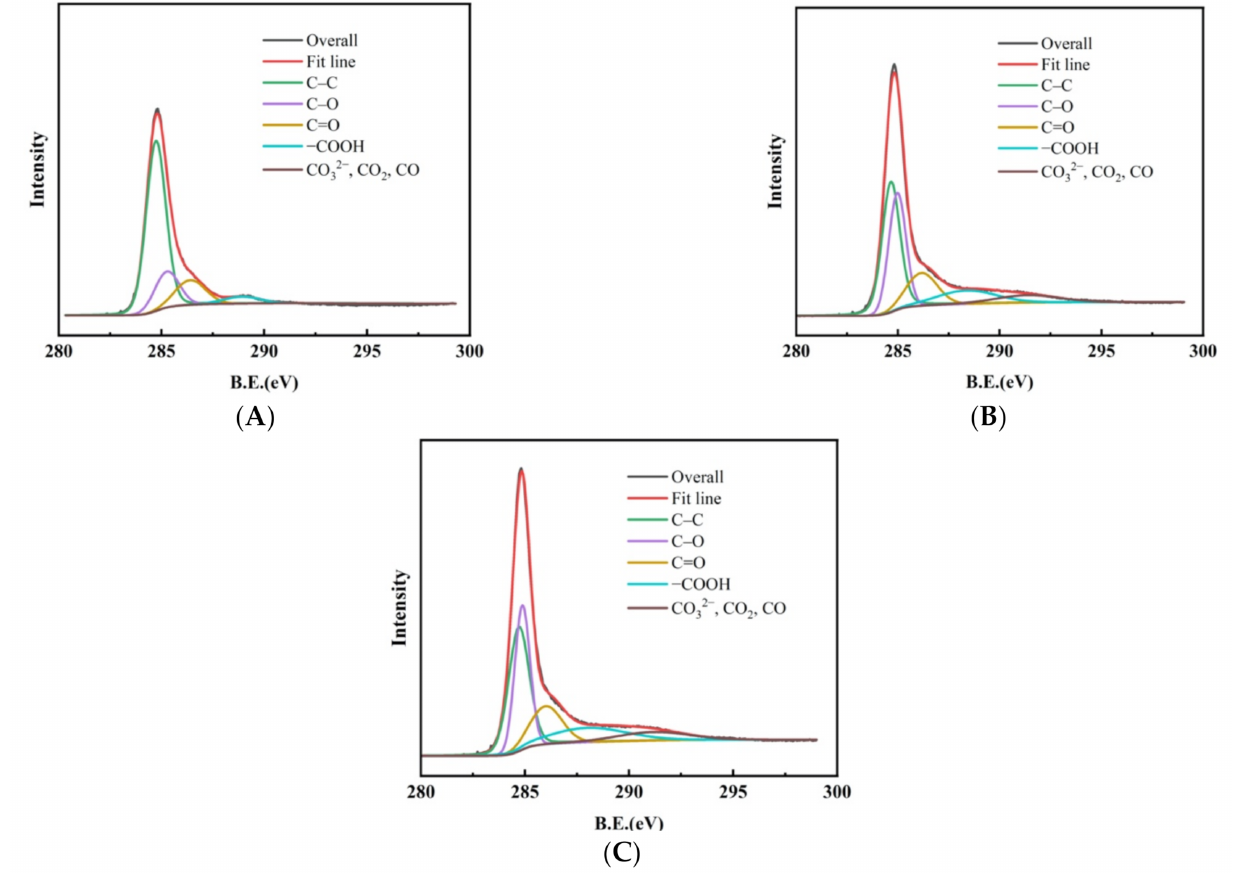
Figure 4. Peak fitting of C1s region of LWACFs activated for 60 min ( A ), 140 min ( B ), and 220 min ( C ) at 800 ◦ C. Table 3. Elemental compositions of the surface of LWACFs with different activation time at 800 ◦ C.